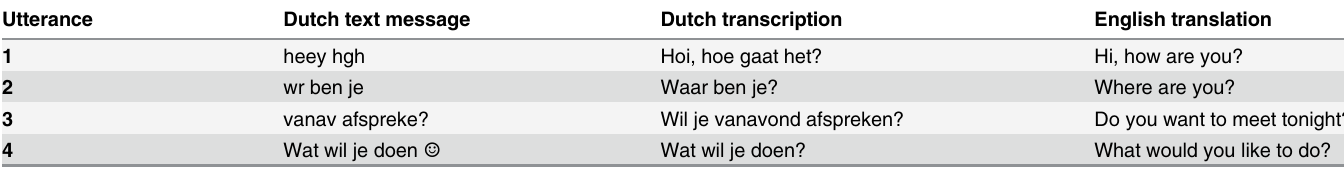
Table 2. Text message in Dutch, Dutch transcription and English